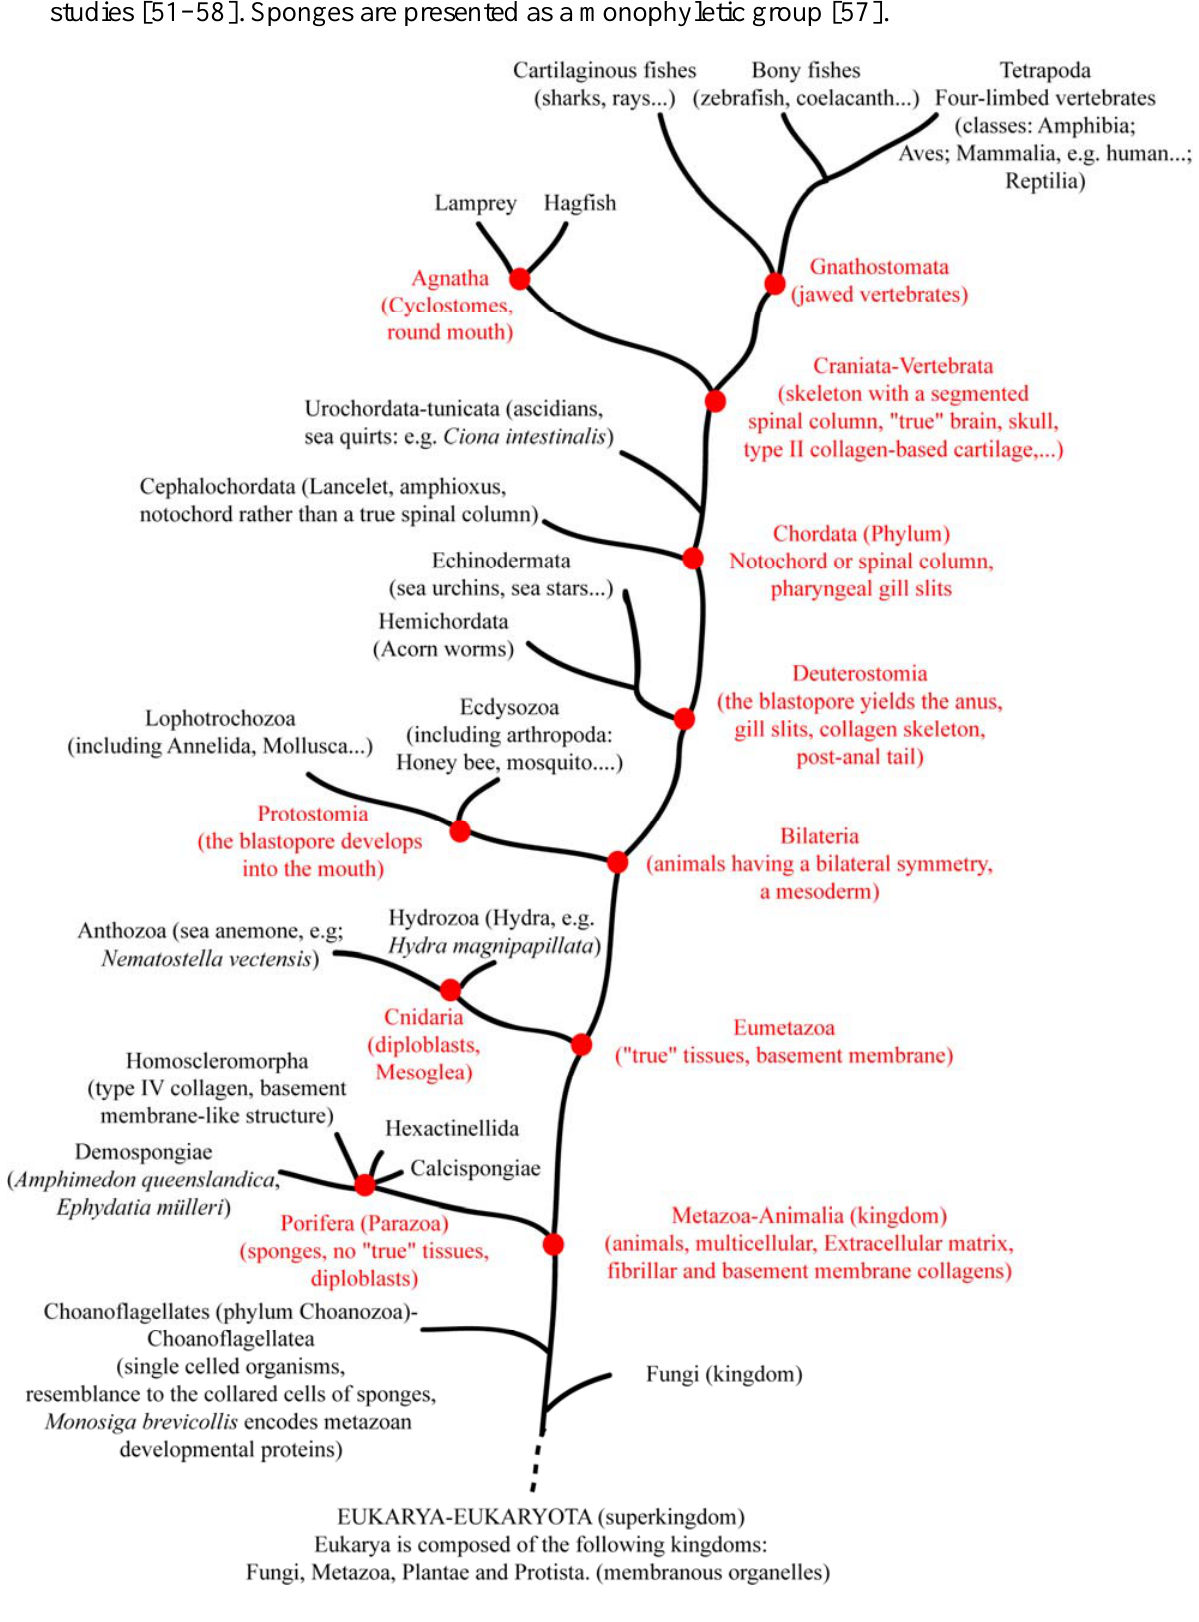
Figure 7. Simplified Eukarya tree of life with a special focus on the kingdom Animalia. Most of the animals discussed in the text are represented. This tree is based on several studies [51–58]. Sponges are presented as a monophyletic group